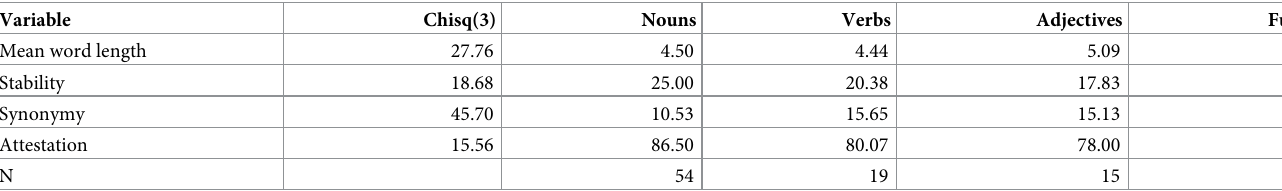
Table 4. Mean word length, stability, synonymy, and attestation by part of speech.